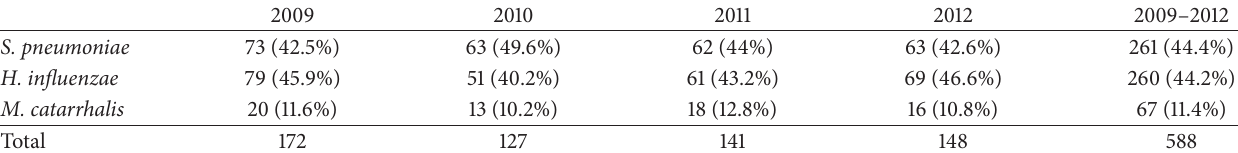
Table 1: Distribution of community-acquired respiratory pathogens by study year